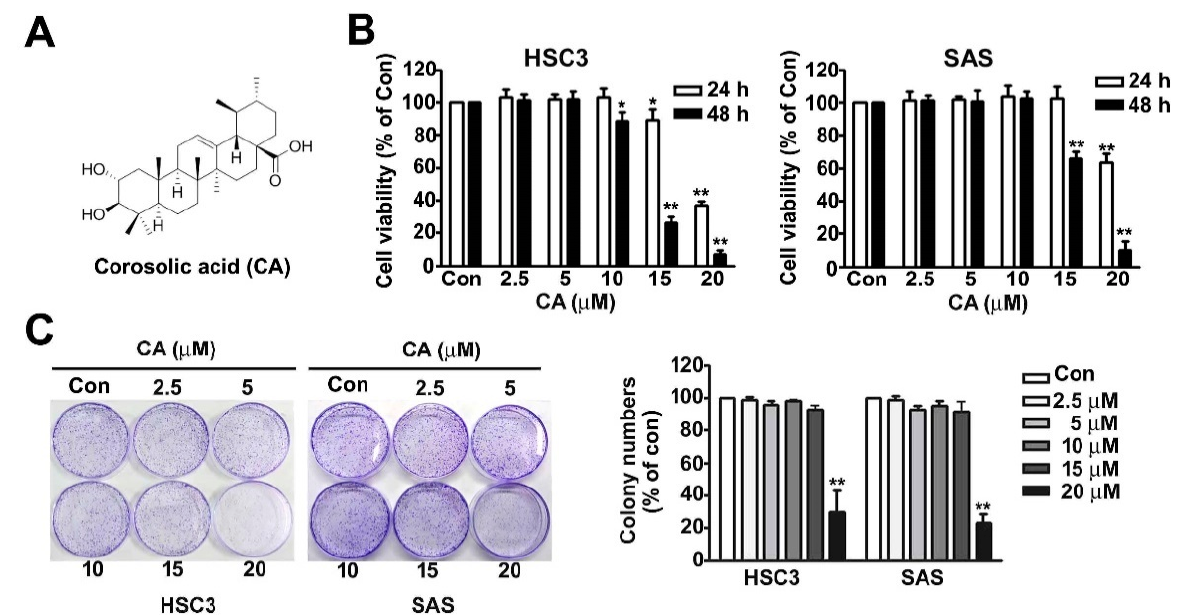
Figure 1. Effect of CA on the viability and cytotoxicity of human HSC3 and SAS OSCC cells. ( A ) Structure of corosolic acid (CA). ( B ) Human HSC3 and SAS cells were exposed to various concentrations (0, 2.5, 5, 10, 15 and 20 µ M) of CA for 24 and 48 h and then measured to observe cell viability using MTT assay. ( C ) The cell proliferation rates of human HSC3 and SAS cells exposed with CA (0, 2.5, 5, 10, 15 and 20 µ M) for 5 days were measured using a colony formation assay. *, p < 0.05; **, p < 0.01 vs. control (line 1), (Mean ± SE, n = 3). Control: untreated cells.